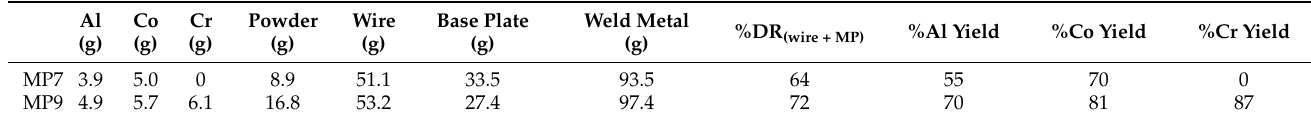
Table 5. Mass balance numbers and percentage yield calculation results for Al, Co and